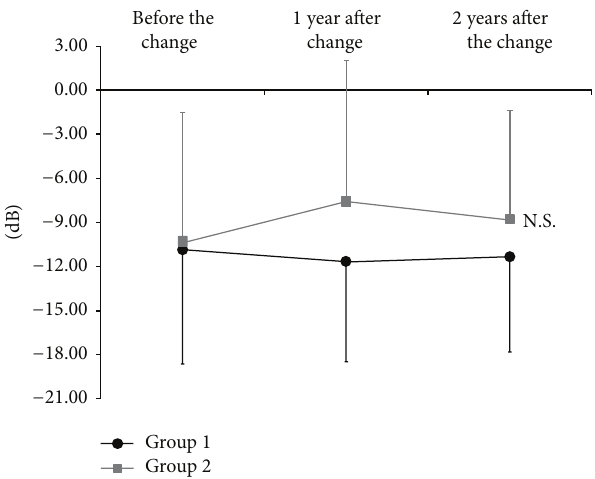
Figure 2: Mean deviation values before and after changing to latanoprost/timolol maleate fixed-combination eye drops or to dor- zolamide/timolol maleate fixed-combination eye drops (Friedmann analysis). There were no significant differences from baseline in mean deviation values in either medication group at any time point examined. Average data are presented and error bars represent one standard